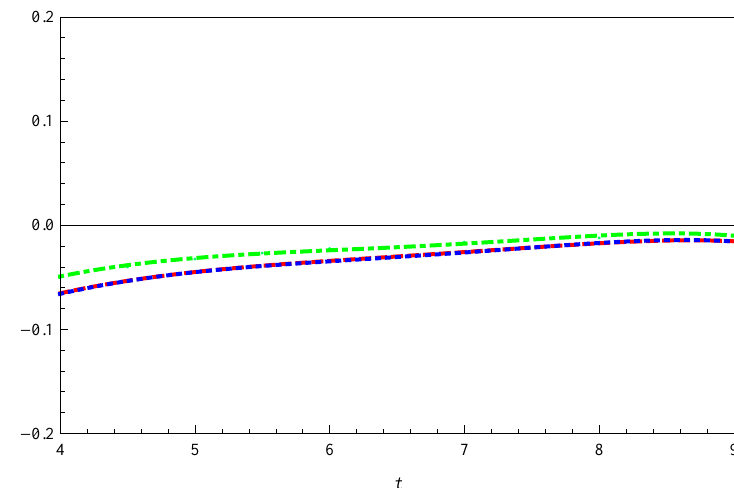
Figure 1. The functions R ( t ) . Notations: the dotted blue line corresponds to ABO2; the dashed red line corresponds to ABO1; the dot-dashed green line corresponds to BLW [10].